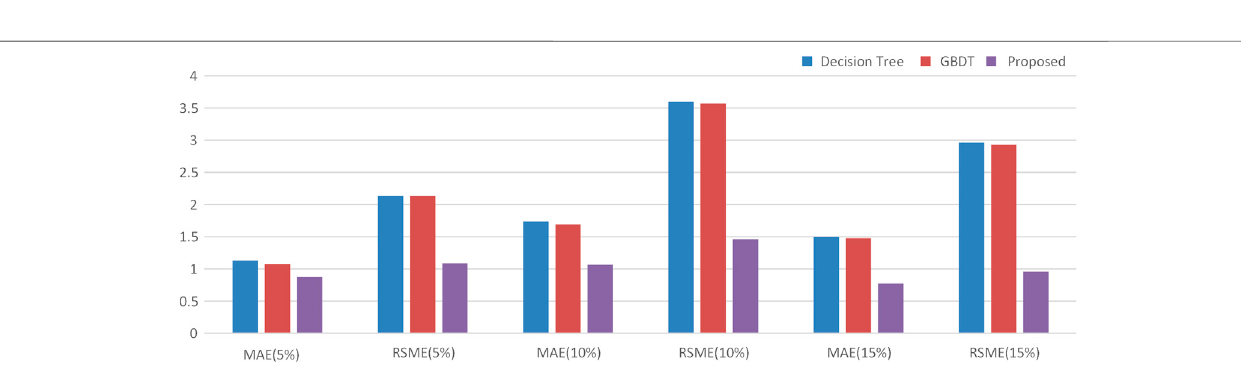
FIGURE 10 | The histogram of the comparative analysis in different outliers detection methods.